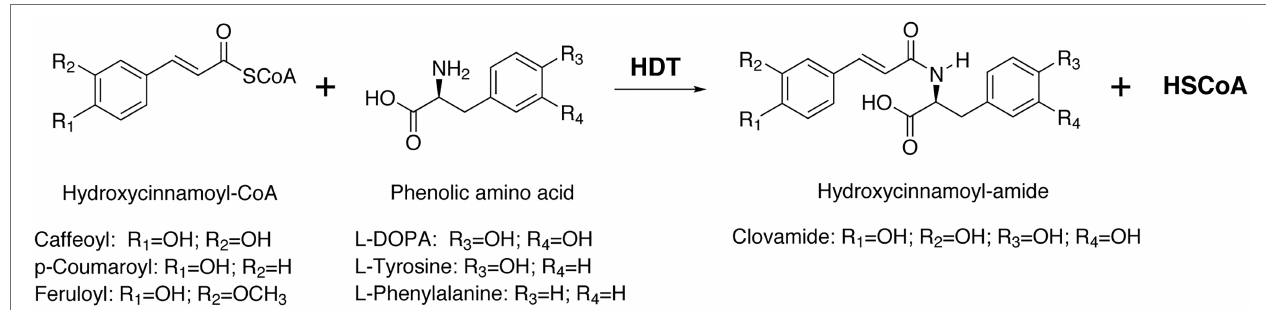
FIGURE 1 | Formation of clovamide and related hydroxycinnamoyl amides by a hydroxycinnamoyl-CoA:L-DOPA hydroxycinnamoyl transferase, HDT. The enzyme transfers a hydroxycinnamoyl moiety from CoA to the amine group on a phenolic amino acid acceptor to form the corresponding hydroxycinnamoyl amide and free CoA (HSCoA). L-Trp and L-Leu can also serve as acceptors for amide formation (not